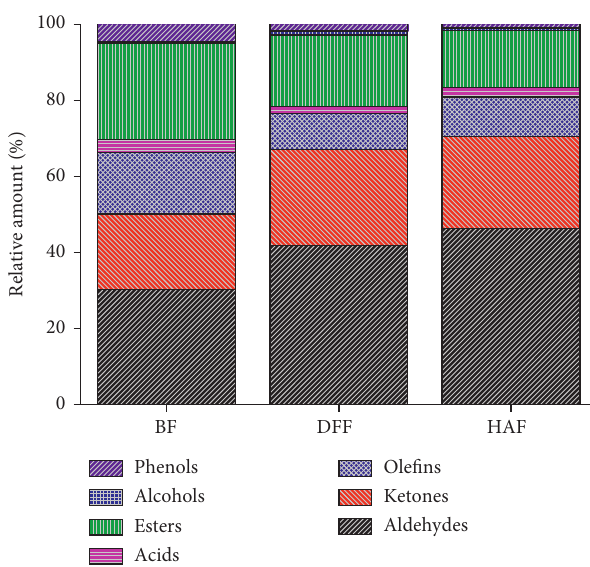
Figure 5: Changes of volatile flavor components of giant sala- mander meatball before and after